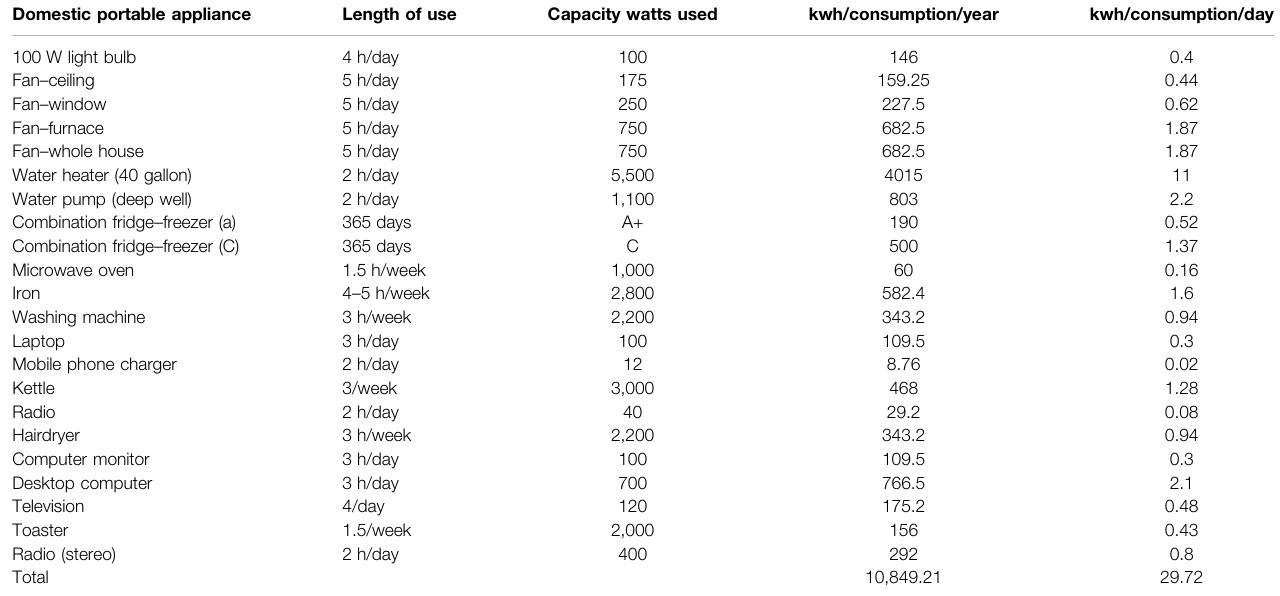
TABLE 4 | Average household electricity consumption (kWh) per day. Domestic portable